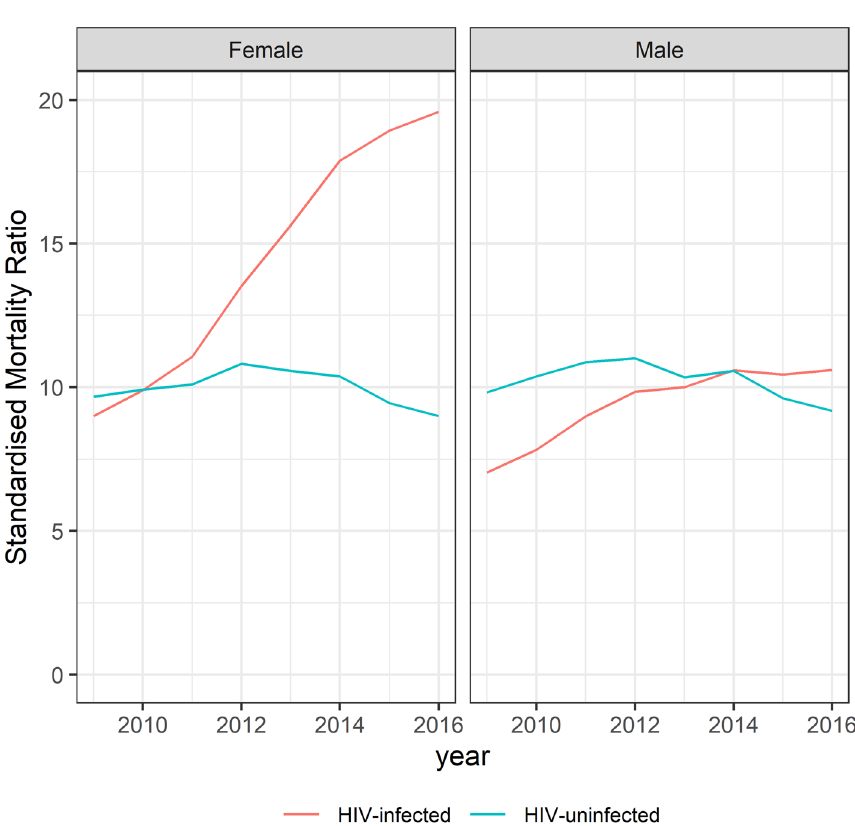
Figure 4. Standardised mortality ratios by HIV and sex of adults (≥ 15 years) on drug-susceptible tuberculosis treatment in South Africa,